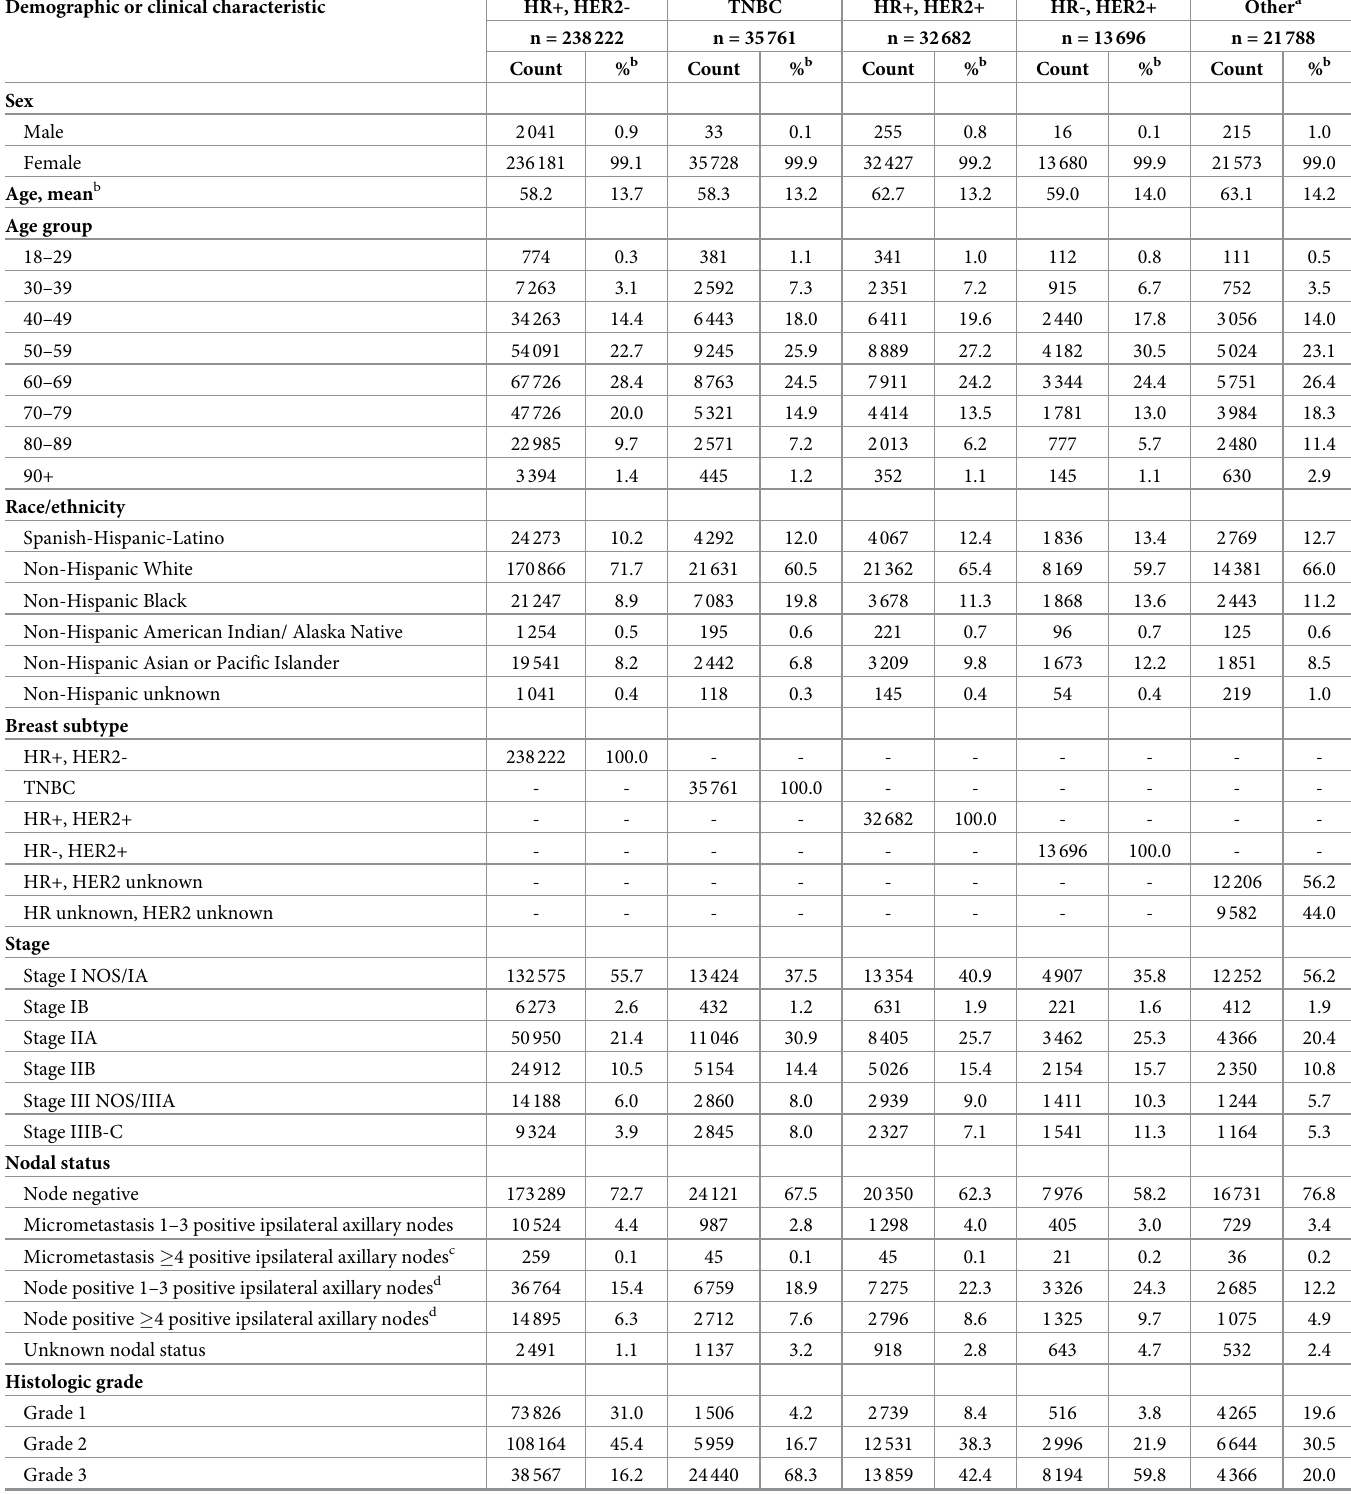
Table 1. Demographic and clinical characteristics among 342,149 patients with EBC, by HR/HER2 subtype. Demographic or clinical